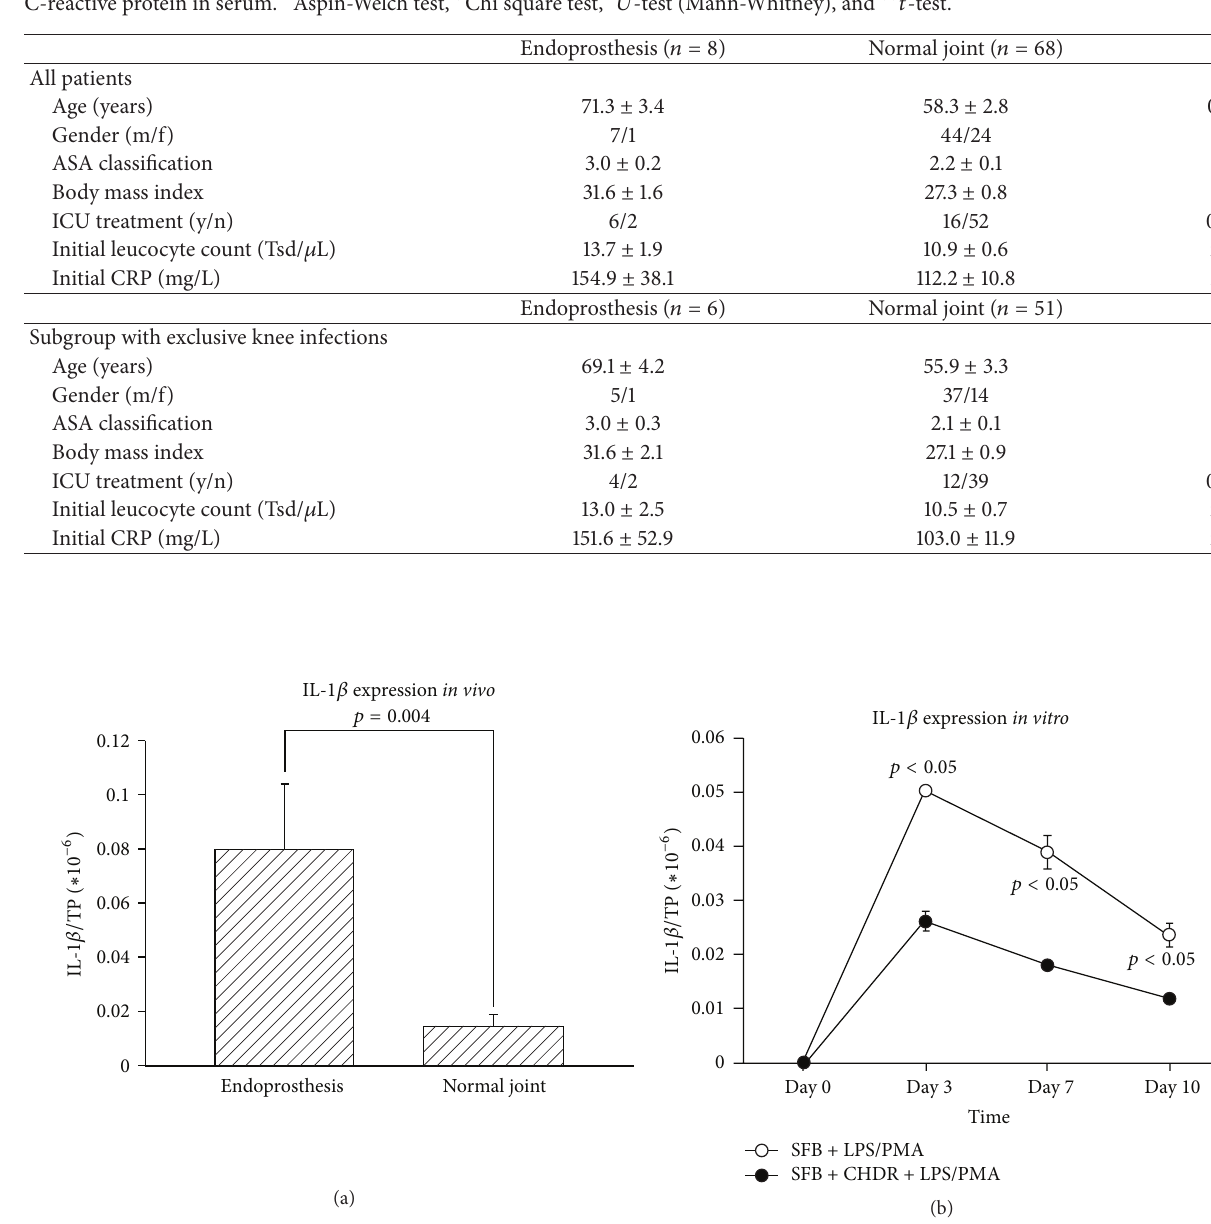
Figure 1: (a) shows that synovial IL-1 𝛽 levels were statistically significantly higher in patients with an endoprosthetic implant (no cartilage) than in those with normal joints (with cartilage). (b) demonstrates the in vitro model’s corresponding data. Similarly, IL-1 𝛽 concentrations were statistically significantly higher in the setting without